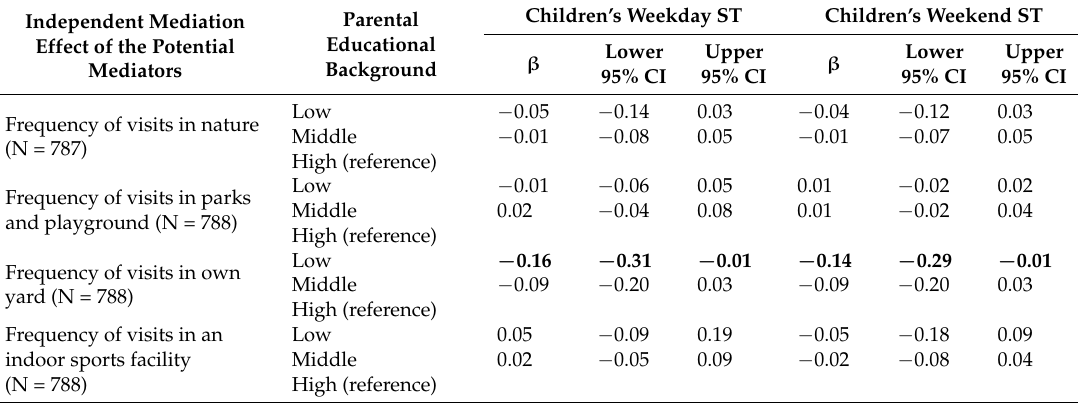
Table 5. Indirect effects of potential mediators in the associations between parental educational background and preschool children’s sedentary time (ST) on weekdays (N = 789) and on weekends (N = 786) adjusted for gender of parental questionnaire respondent, child’s gender and age, measurement season, and parental educational background